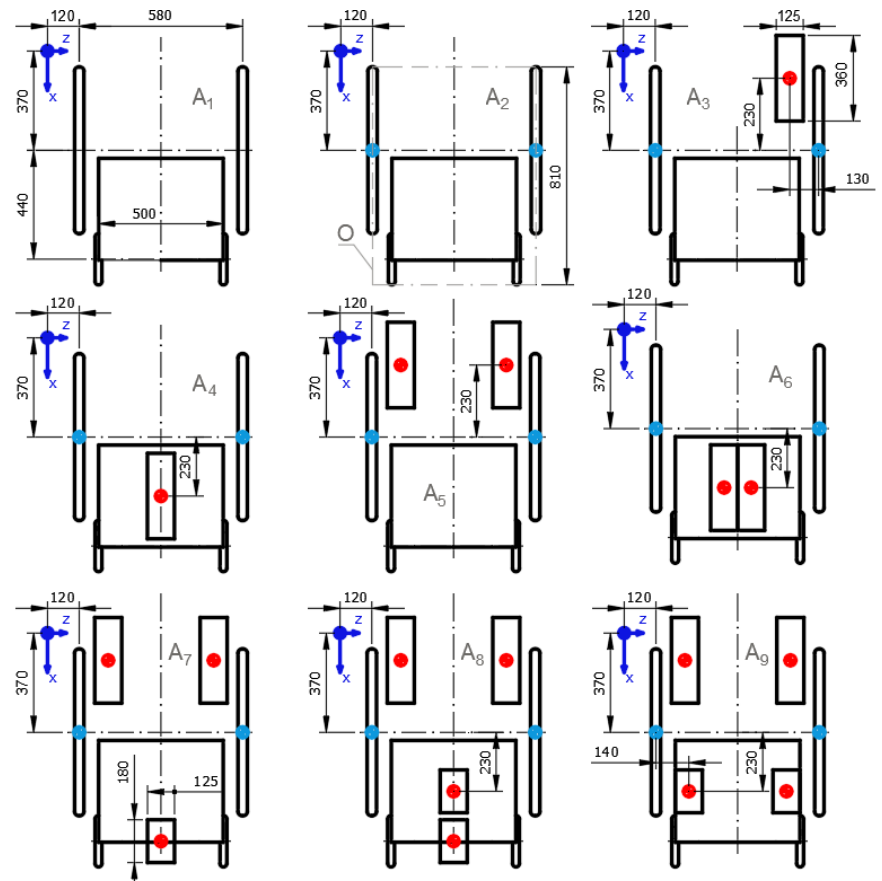
Figure 4. Wheelchair configurations variants for tests and simulations; A 1 – A 9 —designations of individual variants, O —wheelchair outline; red points represent the geometric centre of the battery, blue points represent the origin of the coordinate system, light blue points represent the geometric centre of the rear wheels.